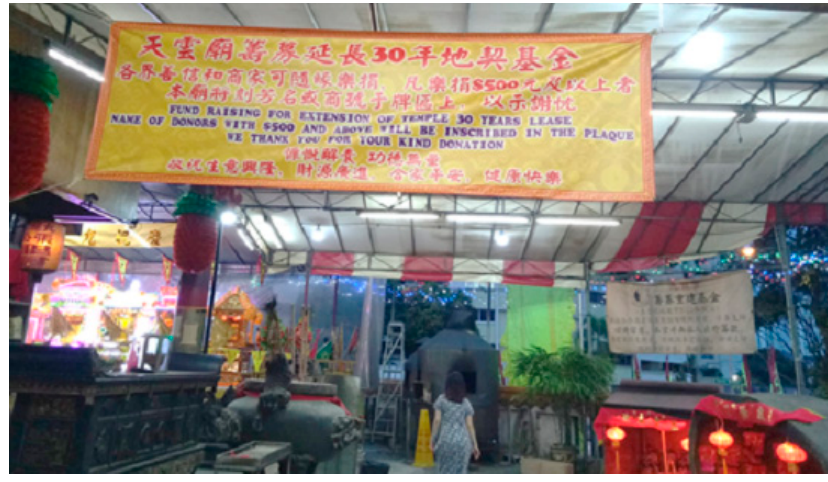
Figure 3. A banner is put up in the Temple seeking donations.